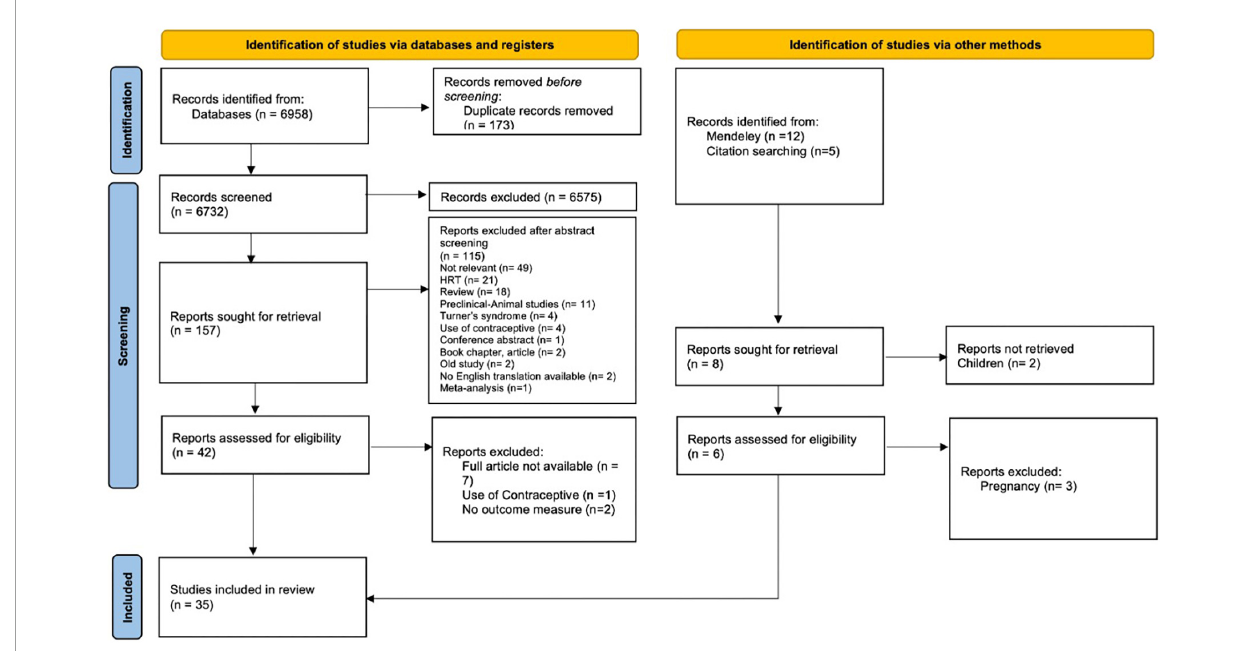
FIGURE2 Preferred reporting items for systematic reviews and meta-analyses 2020 selection process flow.